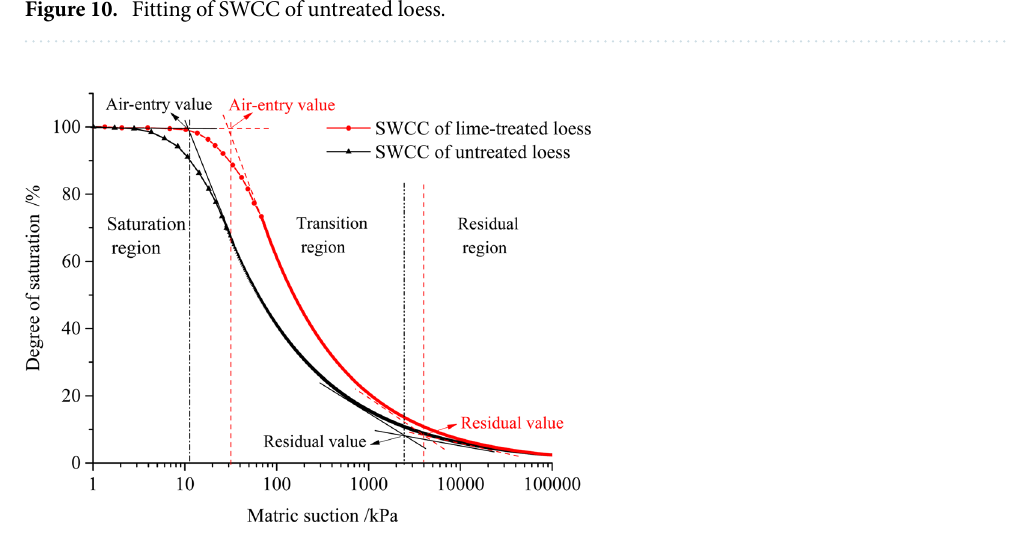
Figure 11. SWCC of loess and lime-treated